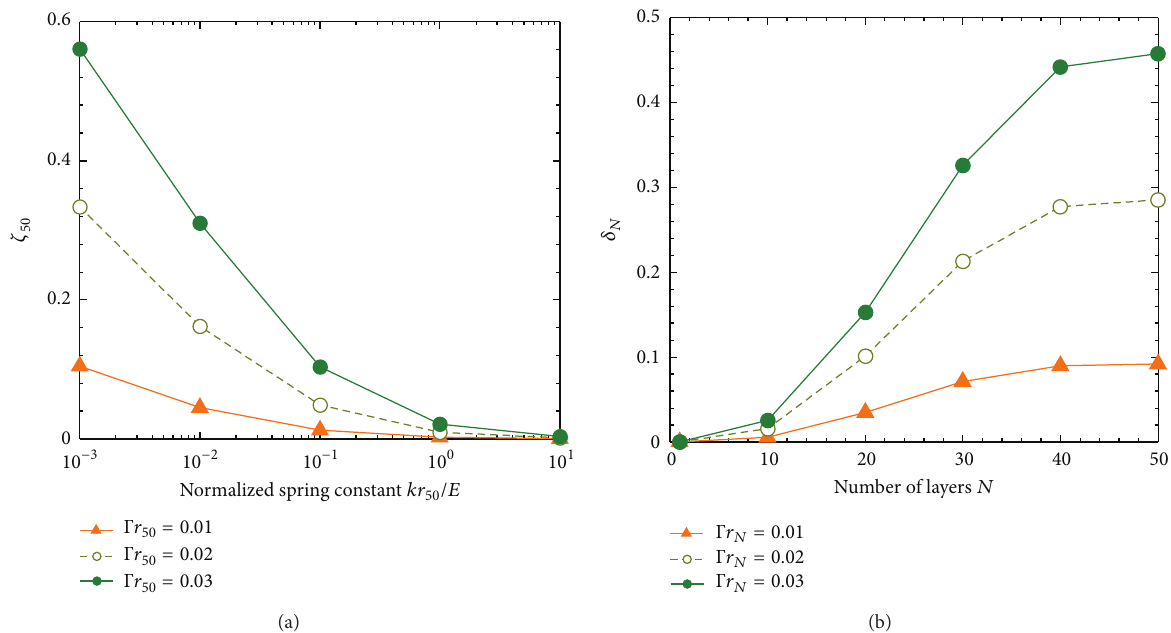
Figure 7: (a) Oblateness suppression caused by interlayer coupling in a 50-layered system. The coupling strength is quantified by the normalized spring constant 𝑘𝑟 50 /𝐸 with 𝐸 being Young’s modulus. (b) Difference in the short radius 𝑟 𝑁 𝜁 𝑁 of deformed cross-sections between the weak and strong coupling conditions: 𝛿 𝑁 ≡ (𝑟 𝑁 𝜁 𝑁 ) 𝑘𝑟